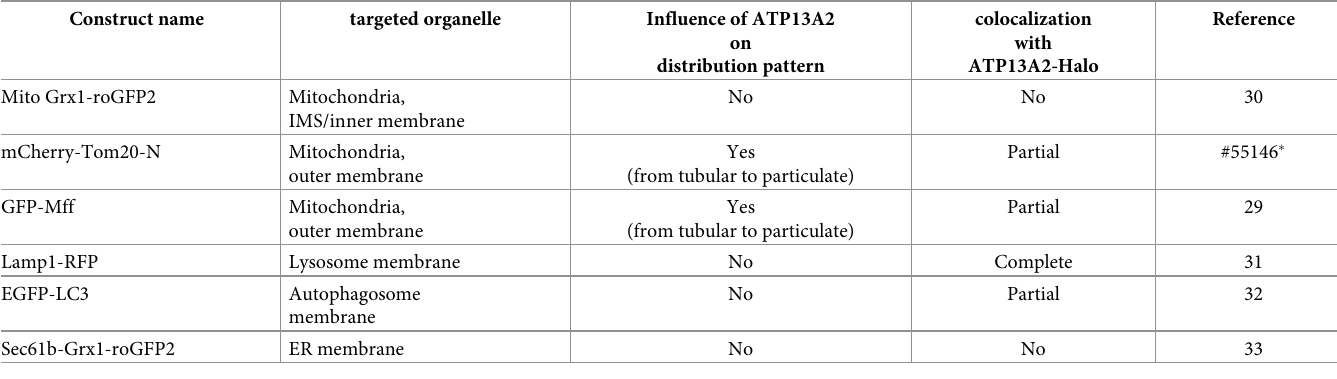
Table 1. List of organelle markers used in the study and summary of the